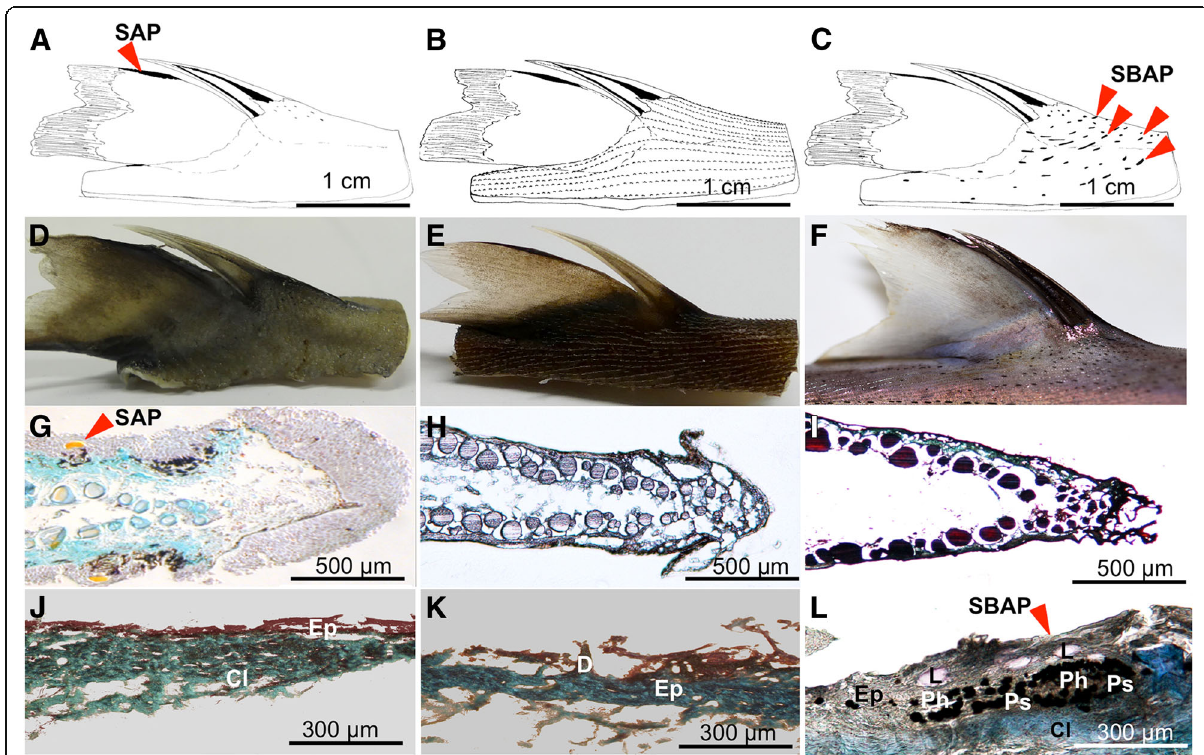
Fig. 2 Spine-associated luminous structure analyses. Schematic view of the second dorsal spine; second dorsal spine images; second dorsal fin cross sections and skin base of the second spine of E. spinax ( a , d , g , j ), E. splendidus ( b , e , h , k ) and E. molleri ( c , f , i , l ) respectively. All sections are Masson ’ s trichrome stained. Cl: connective layer; D: dermal denticle; Ep: epidermis; L: lens; Ph: photocytes; Ps: pigmented sheath; SAP: spine associated photophores; SBAP: spine base associated